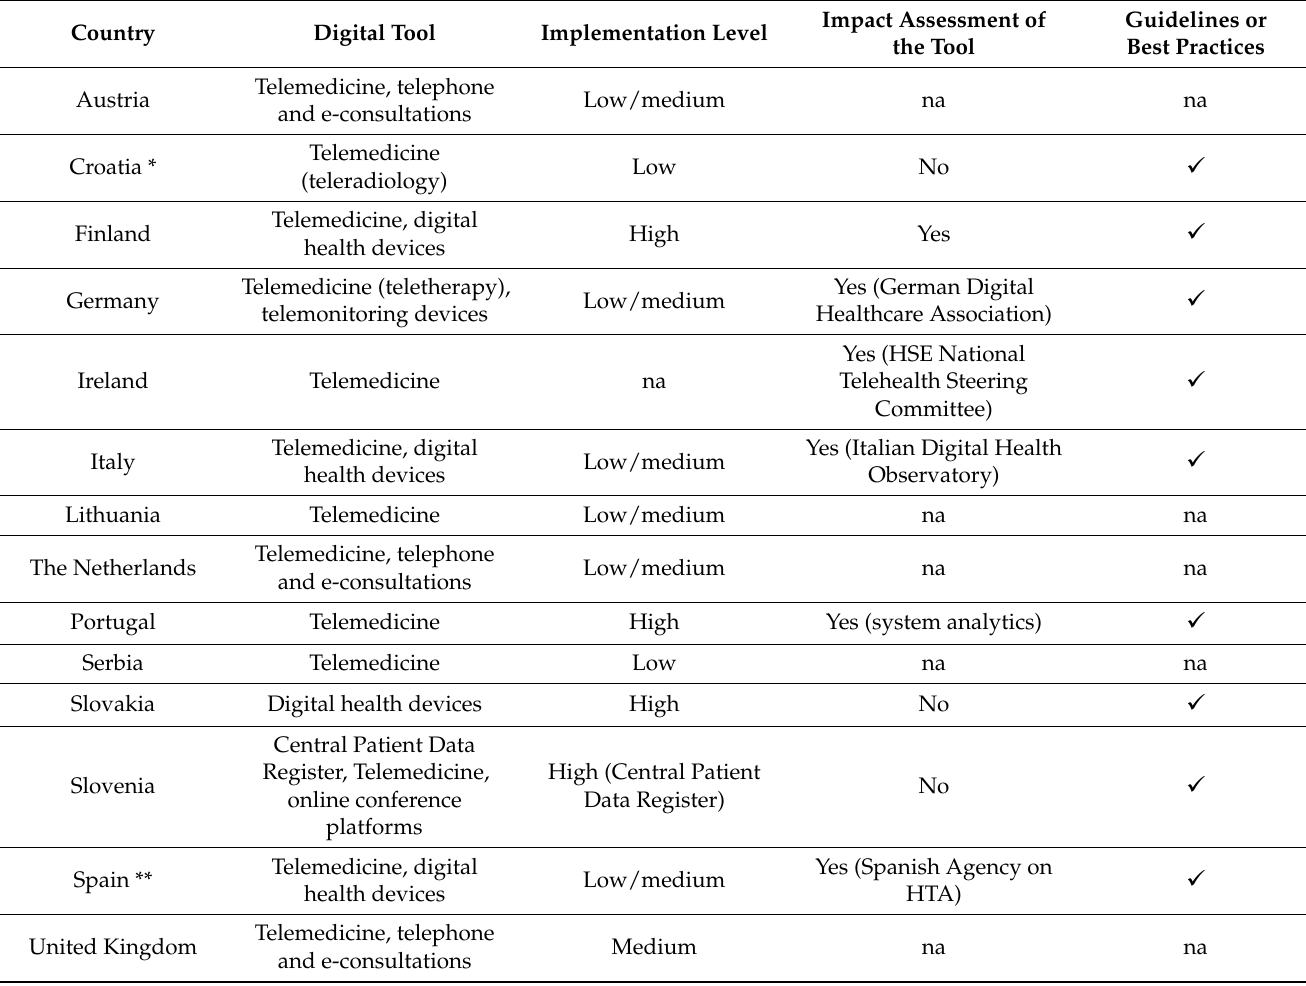
Table 3. Digital tools used for research and development of diagnostics and telehealth.